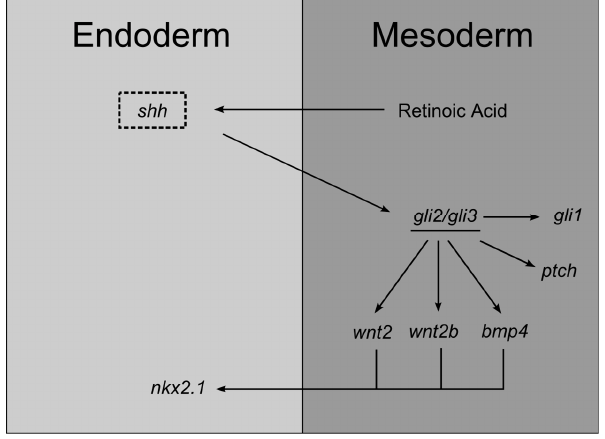
Figure 2. Schematic representation of SHH main interactions during lung endoderm